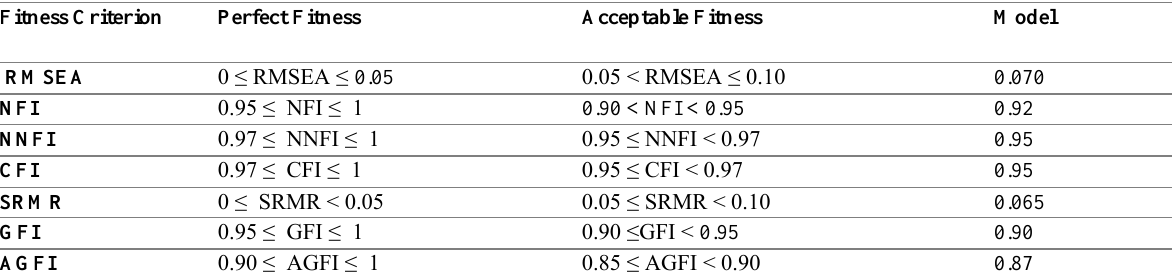
Table 2. Limits and the results of the structural